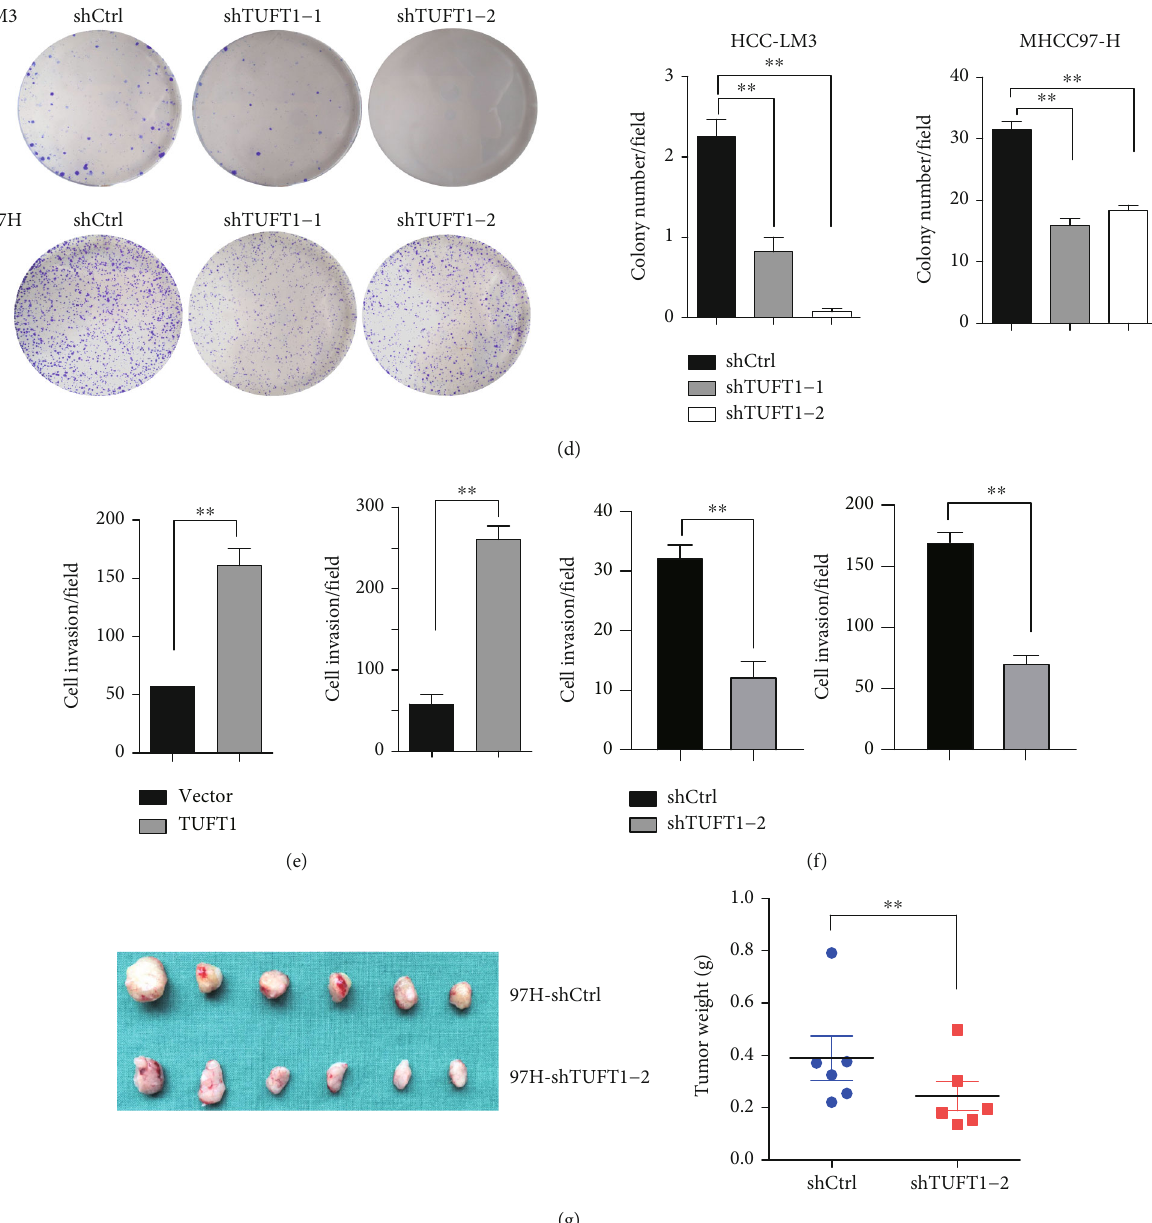
Figure 2: TUFT1 overexpression promotes while knockdown inhibits the oncogenic growth and invasion in HCC cells. (a and b) Cell proliferation analysis in TUFT1 overexpression or knockdown HCC cells. (c and d) Colony formation assay of TUFT1 overexpression or knockdown HCC cells. (e and f) Cell invasion analysis. (g) Tumor burden of control and TUFT1 knockdown cells induced subcutaneous xenograft model. Student ’ s t -test: ∗ P < 0 : 05 and ∗∗ P < 0 : 01